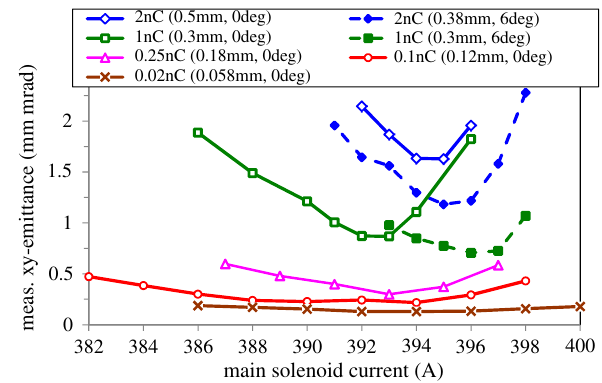
FIG. 14. Measured rms normalized xy emittance as a function of the main solenoid current. Curves for the optimum rms size of the cathode laser spot (size parameter in the legend) are shown.